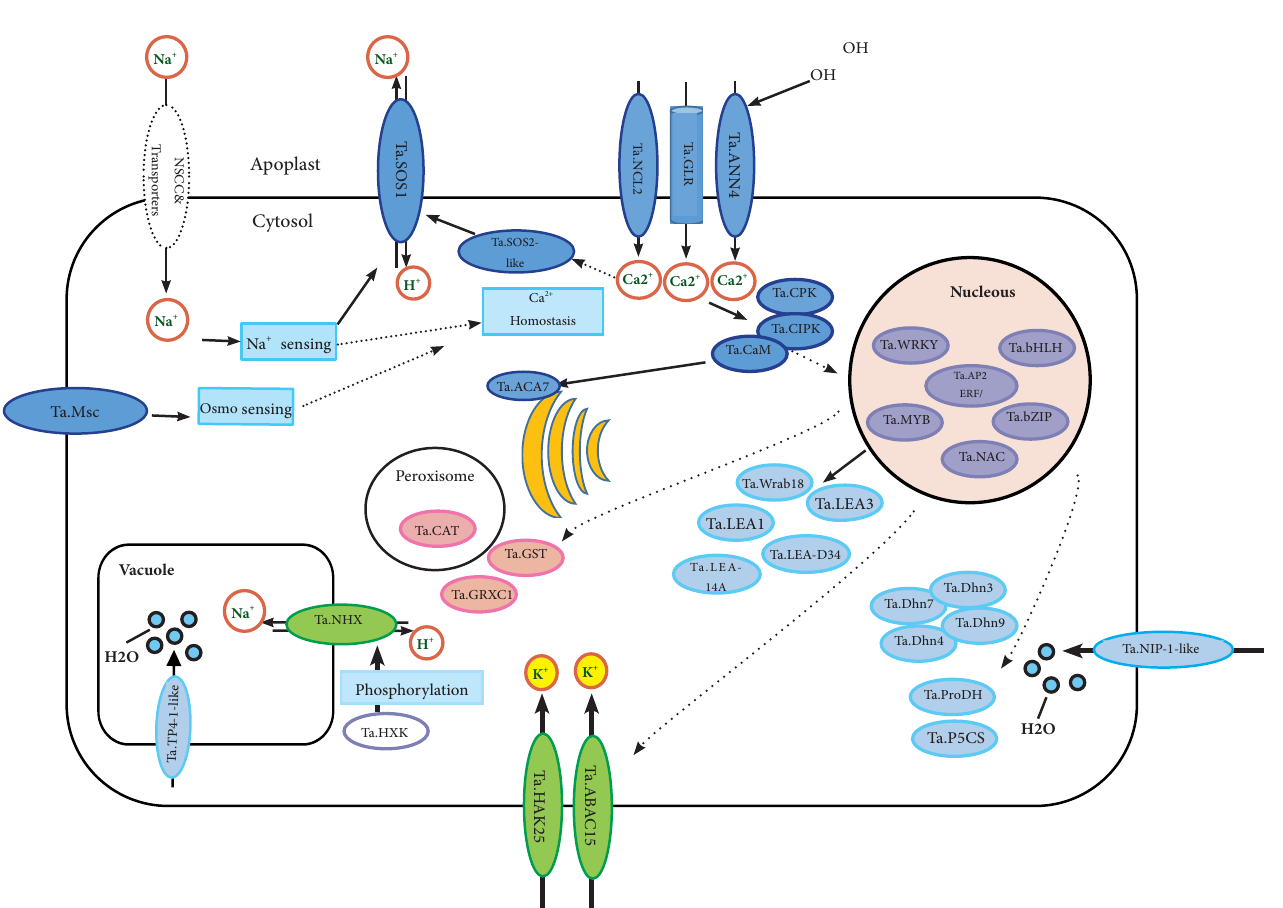
Fig 7. Model proposed for salt stress response in Arg. Sensing and signaling components and transcription factors highlighted in dark blue and purple, respectively. Mechanisms engaged in response to osmotic, ionic and oxidative stresses arising from salinity depicted in light blue, light green and pink,